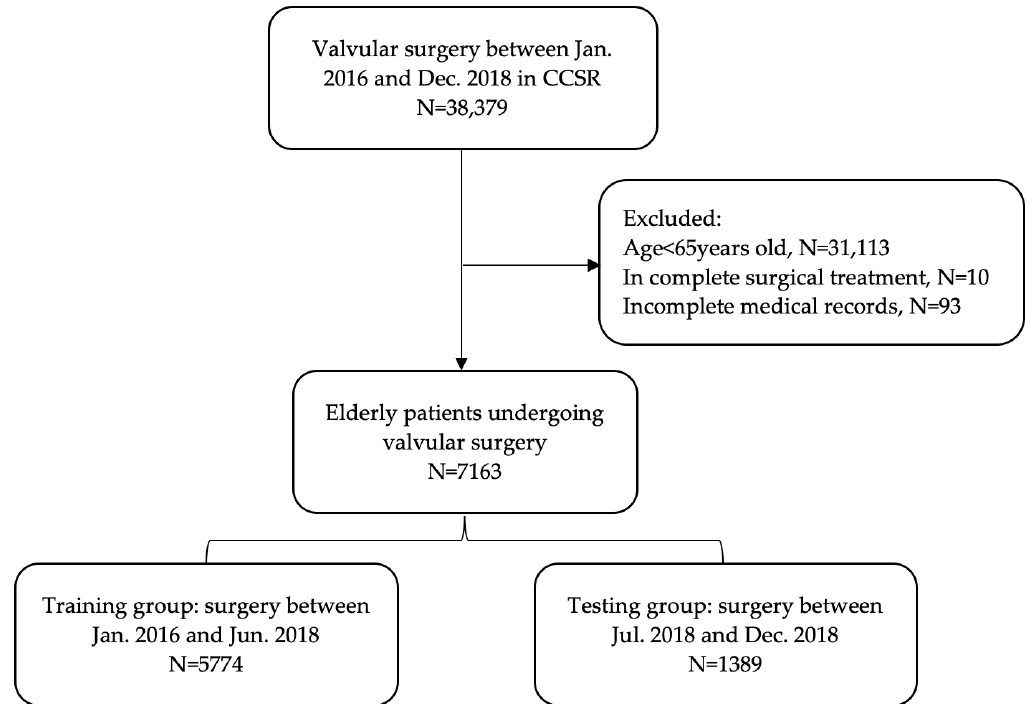
Figure 1. Flow chart of patient enrollment and final sample division.